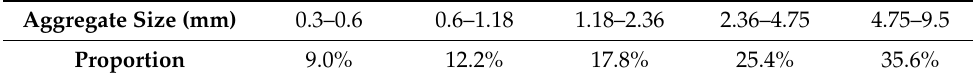
Table 2. The proportion of fillers.